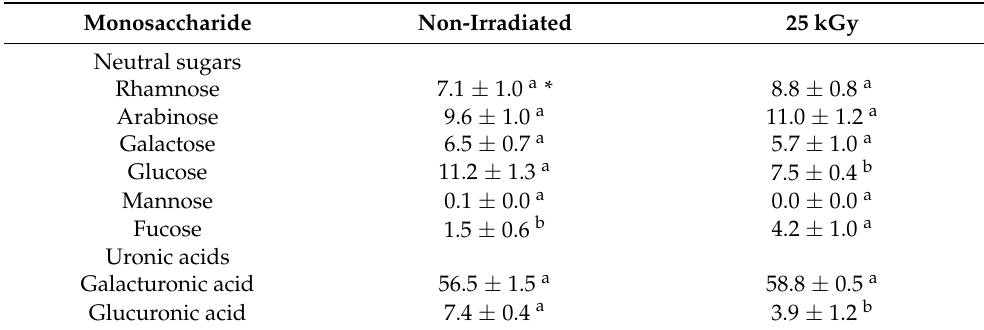
Table 5. Monosaccharide composition of the polysaccharides isolated from non-irradiated and 25 kGy-irradiated RH fruits (mol%).